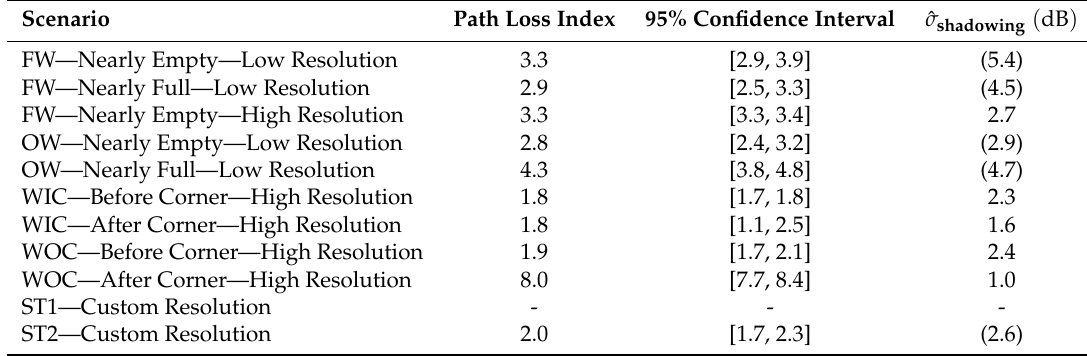
Table 1. The fitted path loss indices together with their 95% confidence intervals and the standard deviation due to the shadowing.